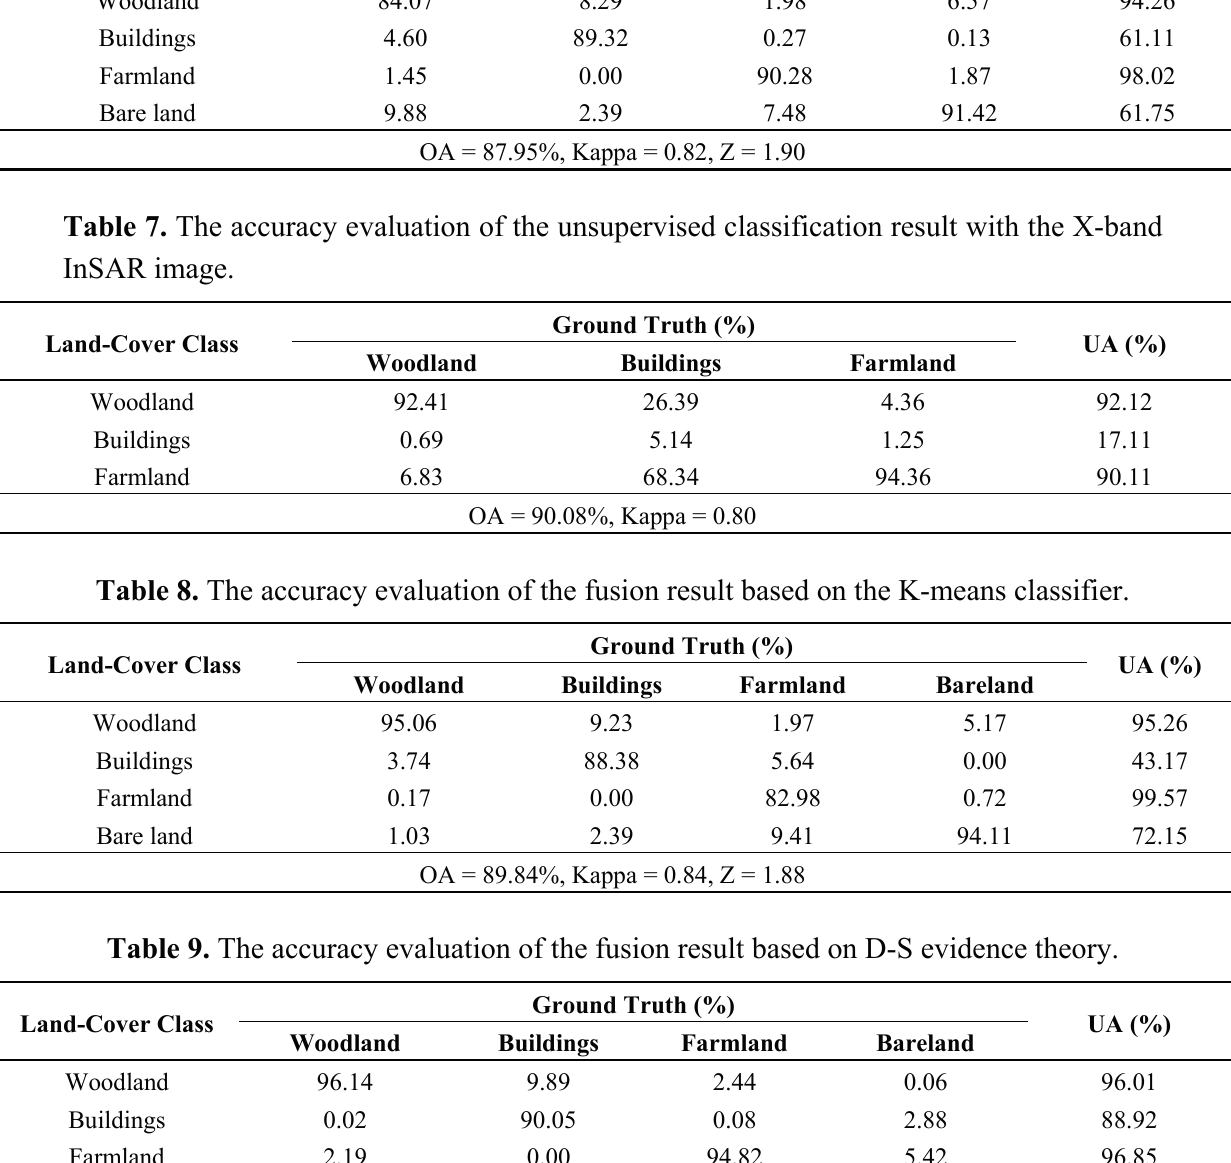
Table 6. The accuracy evaluation of the supervised classification result with the P-band PolSAR image. Land-Cover Class